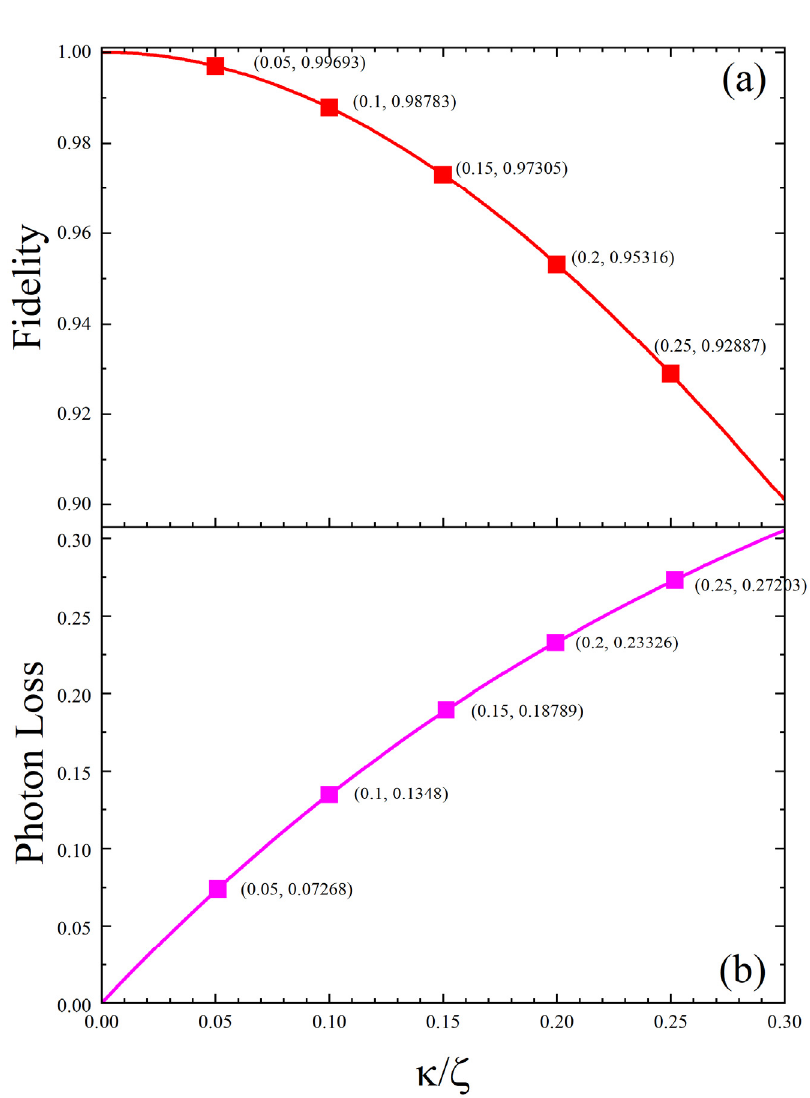
Figure 3. ( a ) Fidelity of the photonic two-qubit phase gate. ( b ) Photon loss during the implementation of the phase gate, where κ 1 = κ 2 = κ , ζ = g 1 g 2 , g 1 = g 2 = g , ε = 5 g 4 ε